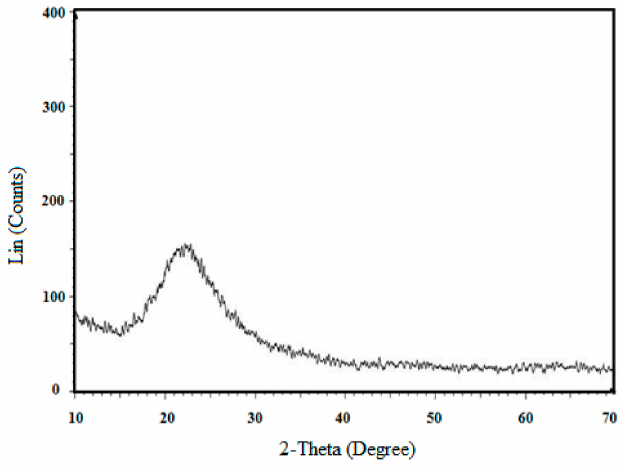
Figure 3. XRD pattern of